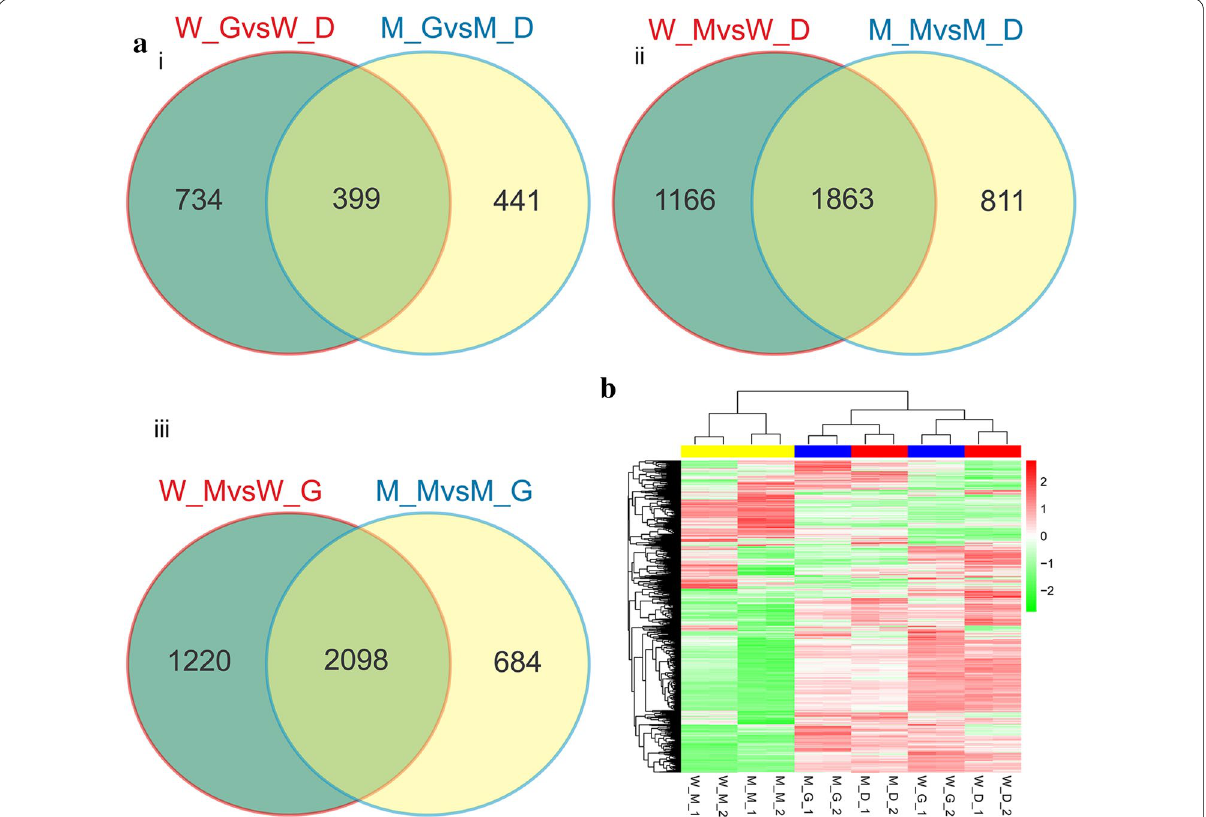
Fig. 1 Statistics and heatmap of DEGs using three carbon sources in Δmig1Δmig2Δnrg1-Mit1 (Mut) and wild (WT) strains. a DEG statistics under three carbon sources or strain types: (i) DEGs in Mut or WT strains between dextrose and glycerol groups, (ii) DEGs in Mut or WT strains between methanol and dextrose groups, (iii) DEGs in Mut or WT strains between methanol and glycerol groups. b DEG heatmap using three carbon sources and different strain types. Red stripes for dextrose, blue for glycerin, and yellow for